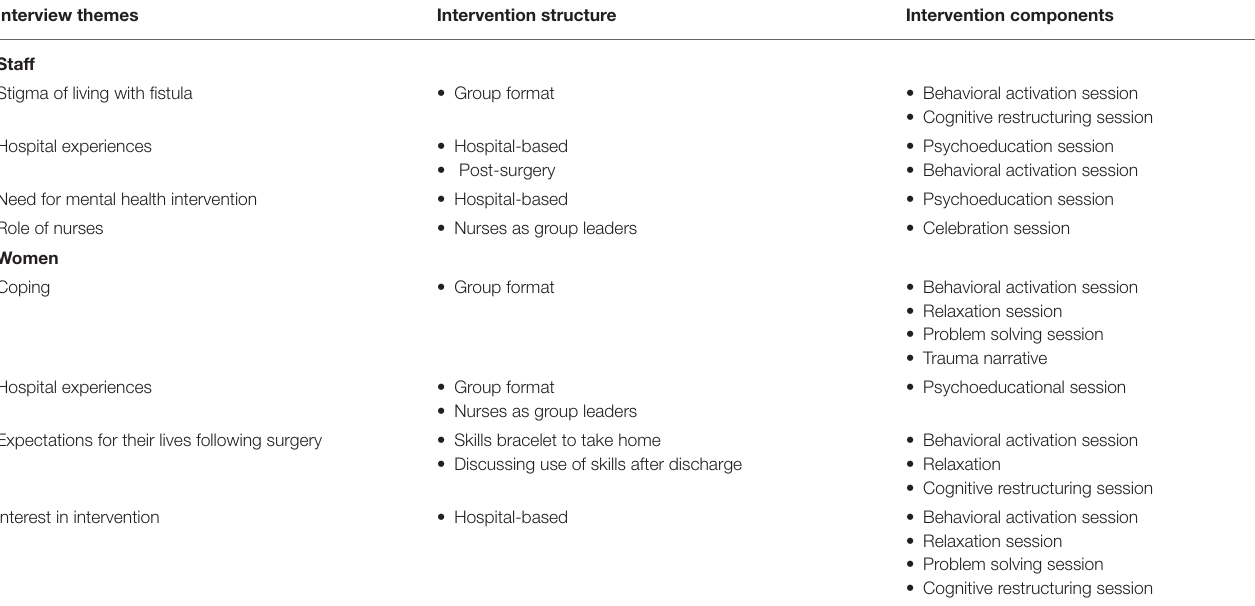
TABLE 5 | Using themes from qualitative interviews to inform intervention structure and